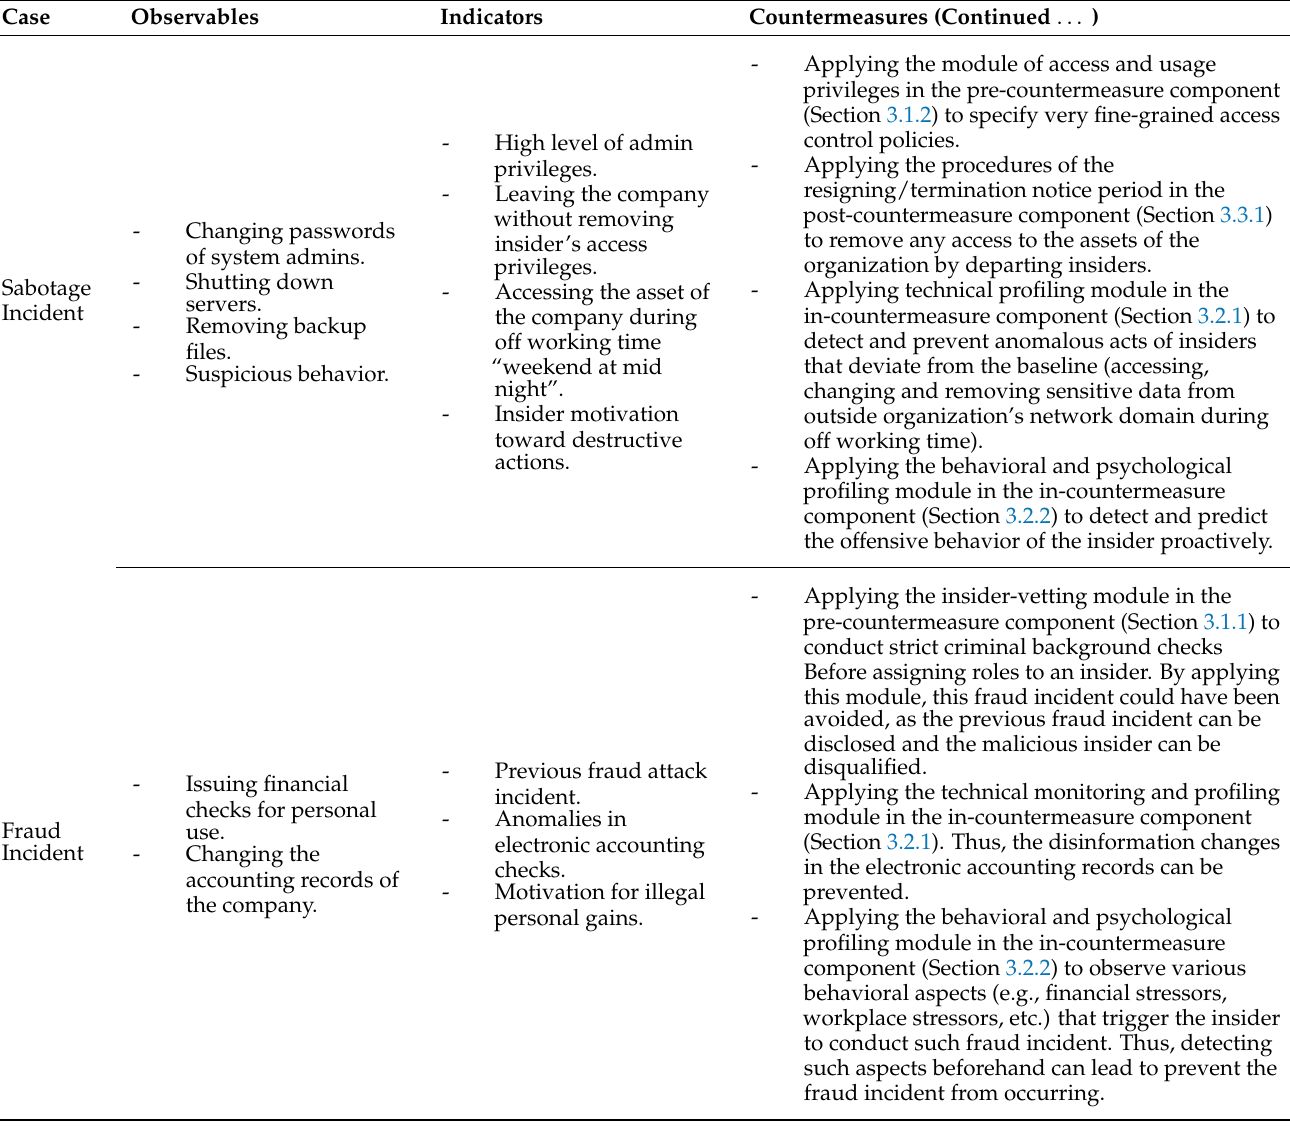
Table 8. A summary of applying the framework on insider threat